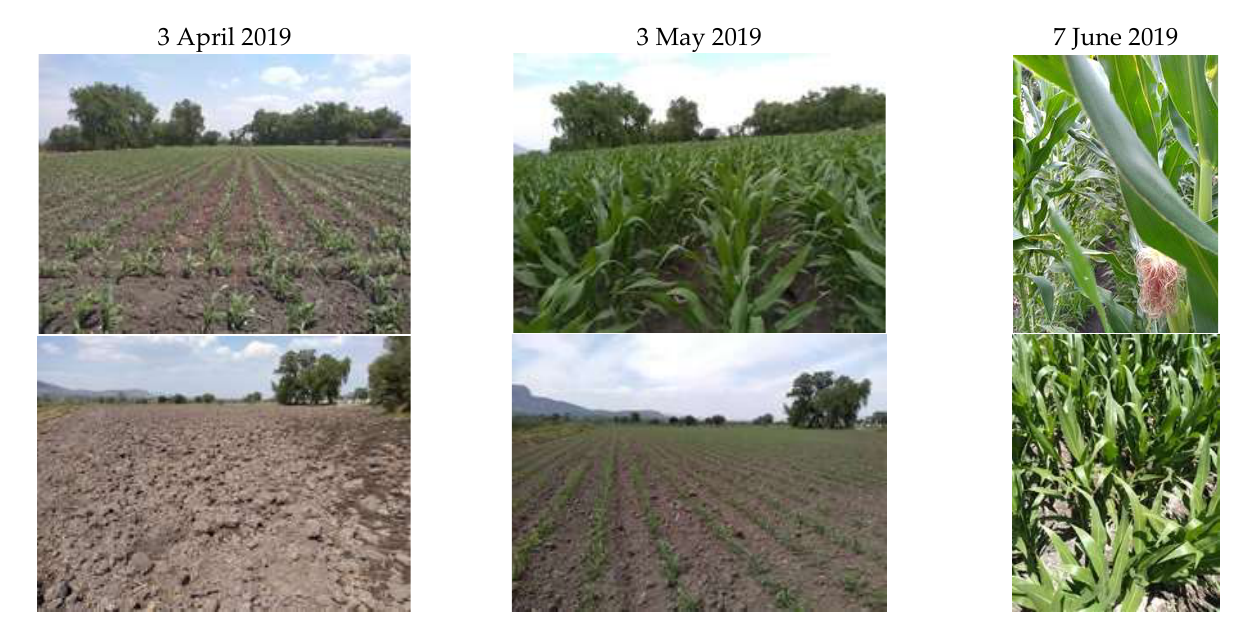
Figure 8. Differences in the sowing date of the same crop (corn).